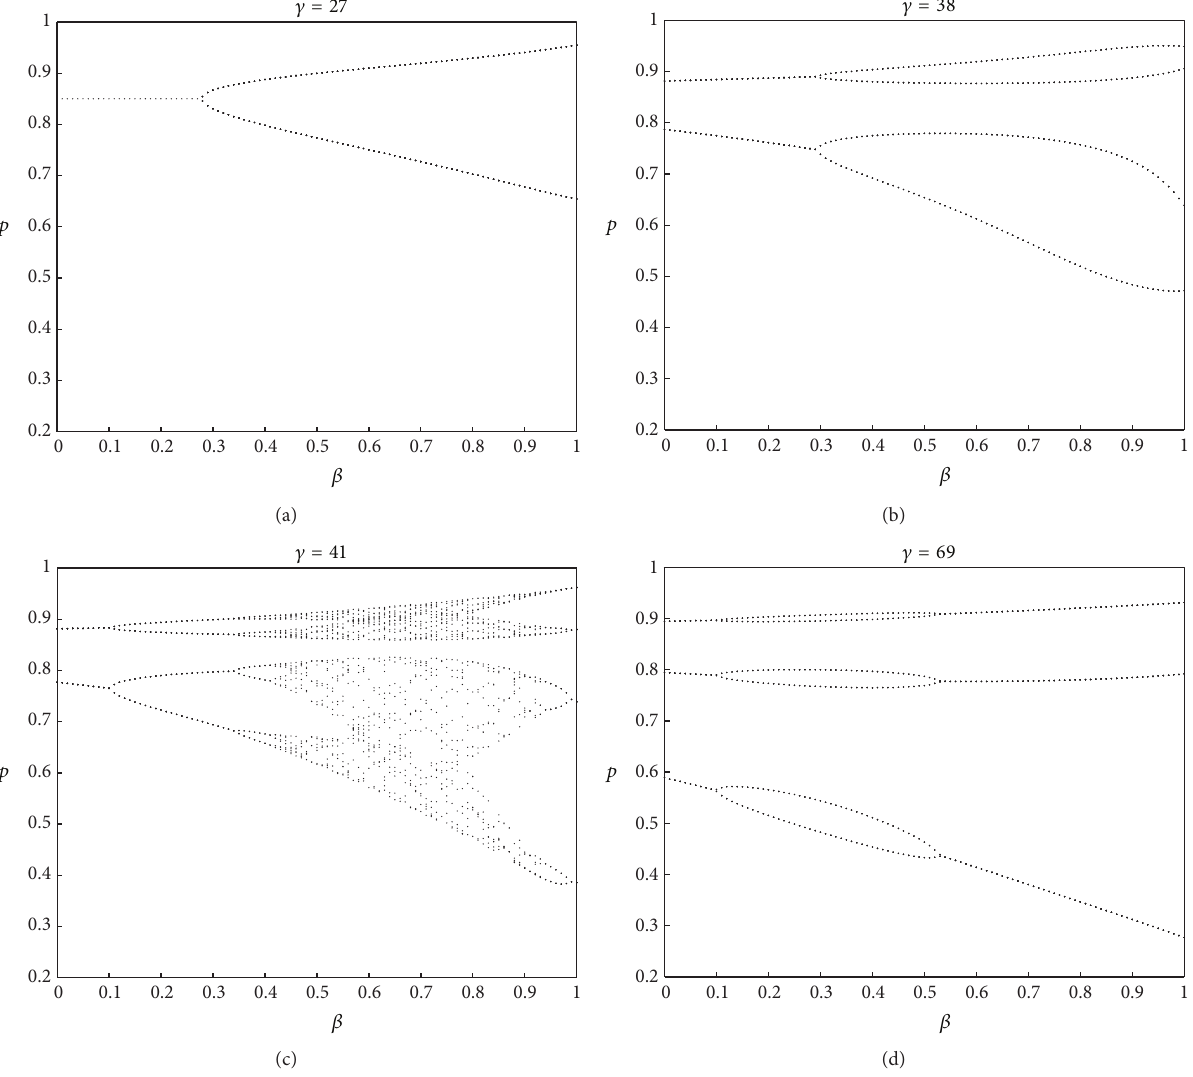
Figure 2: 𝑢 11 = 1 , 𝑢 12 = 0.5 , 𝑢 22 = 0 , and 𝜉 = 0.85 . When 𝛾 = 27 , (𝑝 ∗ , 𝐹 ∗ ) is stable for 𝛽 ∈ (0, 𝛽 ∗ ) ( 𝛽 ∗ = 0.27875 ). Stable 2-periodic points emerge at 𝛽 = 𝛽 ∗ . When 𝛾 = 38 , stable 2-periodic points become stable 4-periodic points with the increase of 𝛽 . When 𝛾 = 41 , there is